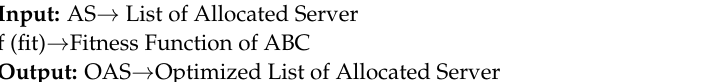
Algorithm 2. Algorithm of ABC (Artificial Bee Colony) with Fitness